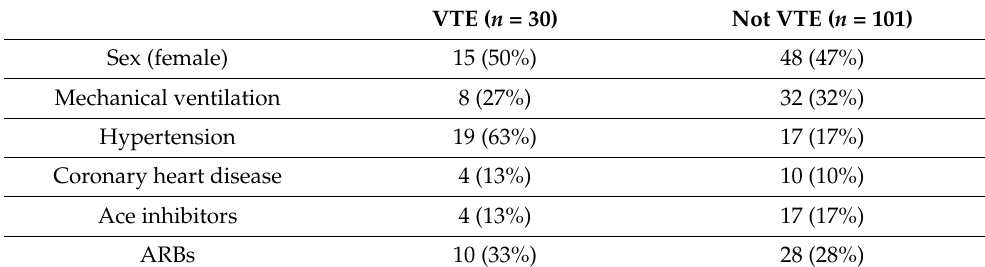
Table 4. Dichotomous characteristics of COVID-19 patients according to VTE development.